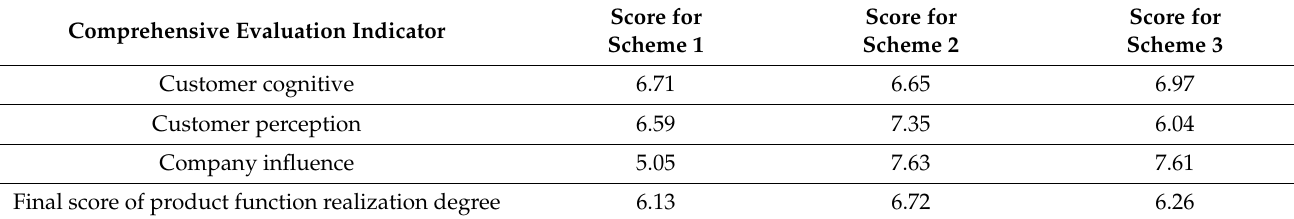
Table A4. Final evaluation results of product function realization